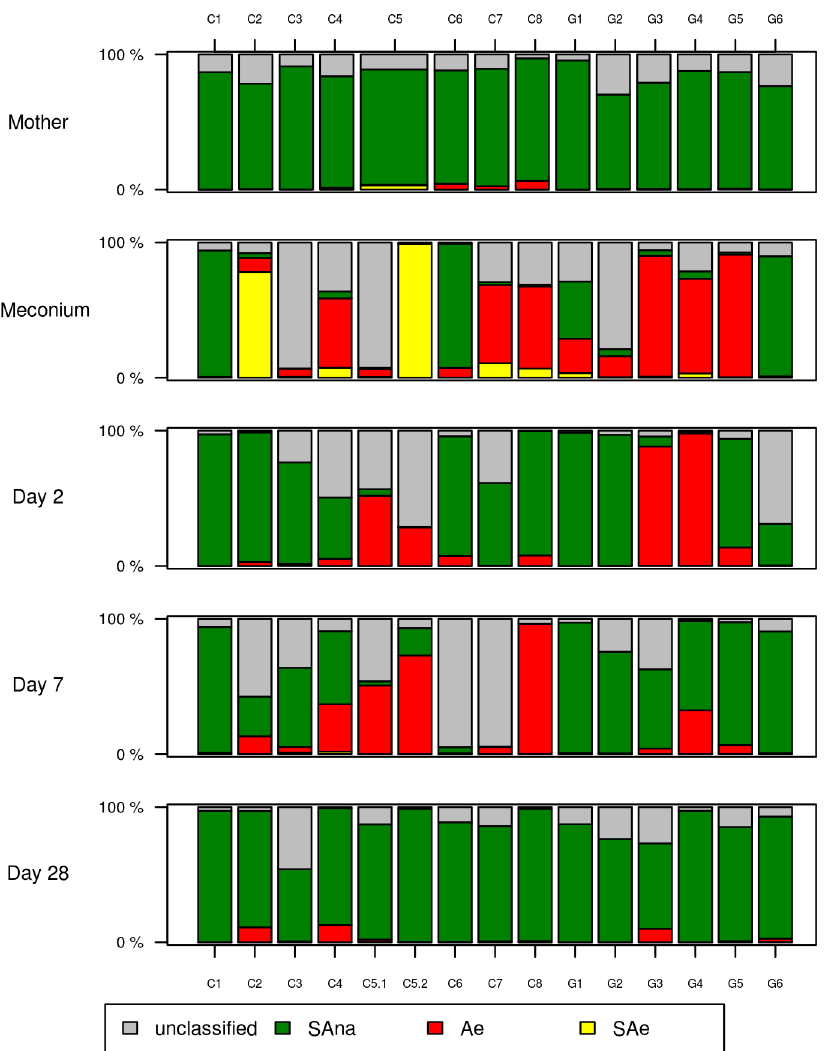
Fig 3. Relative abundances of aerobic or facultative anaerobic (Ae, red), strictly aerobic (SAe, yellow) and strictly anaerobic (SAna, green) bacteria in all samples. Grey areas represent the relative abundances of OTUs not attributed to a genusor attributed to a genuswhose respiratory mode is unknown.